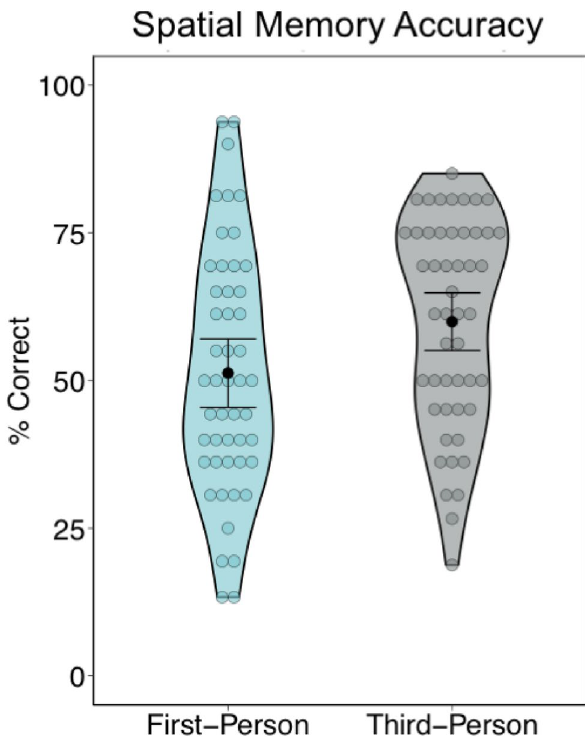
Figure 3. Spatial Memory Accuracy. There was a significant increase in spatial memory accuracy in the third-person compared to the first-person avatar perspective condition. Colored circles reflect mean for each participant, black circles represent the mean within each condition, and error bars reflect the 95%